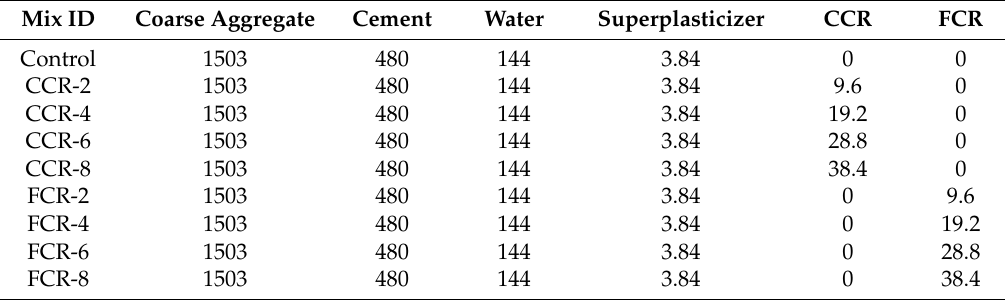
Table 4. Mix ratio of pervious concrete (in kg/m 3